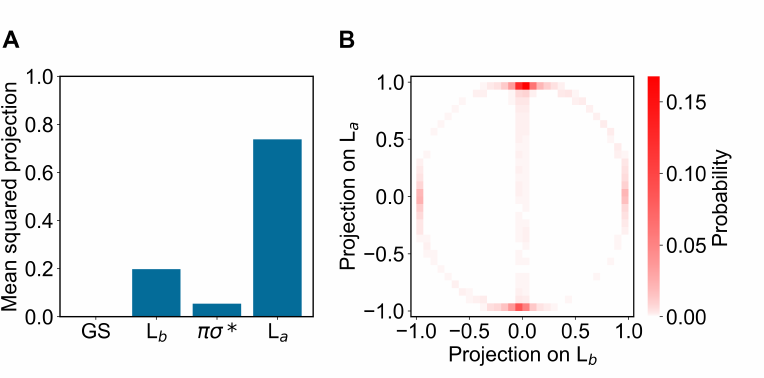
Figure 4. ( A ): Mean-squared projections of the perturbed second electronic excited state of indole, on the first four unperturbed electronic eigenstates (the ground state GS, the excited states L b , L a and the dark state πσ ∗ , in the figure ordered according to increasing energy) as obtained at the (unperturbed) ground-state geometry by the ground-state MD ensemble. ( B ): Probability distribution of the pair values of the projections of the perturbed second electronic excited state of indole, on the L b and L a states as obtained at the (unperturbed) ground-state geometry by the ground-state MD